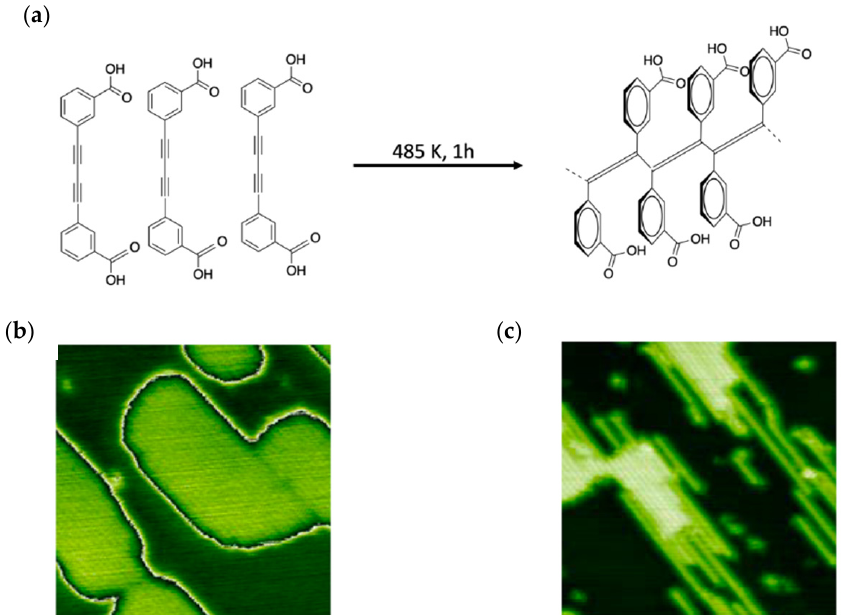
Figure 8. ( a ) Chemical pathway for the thermal-induced polymerization of 3,3 ′ -(1,3-butadiyne-1,4-diyl)bisbenzoic acid into a poly(substituted)diacetylene chains. ( b ) AFM image (50 × 50 nm 2 ) of self-assembled 3,3 ′ -(1,3-butadiyne-1,4-diyl)bisbenzoic acid molecules on the calcite (10.4). ( c ) AFM image (50 × 50 nm 2 ) recorded after thermal annealing of 3,3 ′ -(1,3-butadiyne-1,4-diyl)bisbenzoic acid molecules.